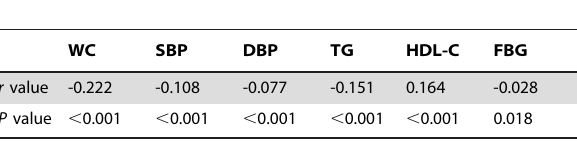
Table 2. Correlations between GH and features of the metabolic syndrome.